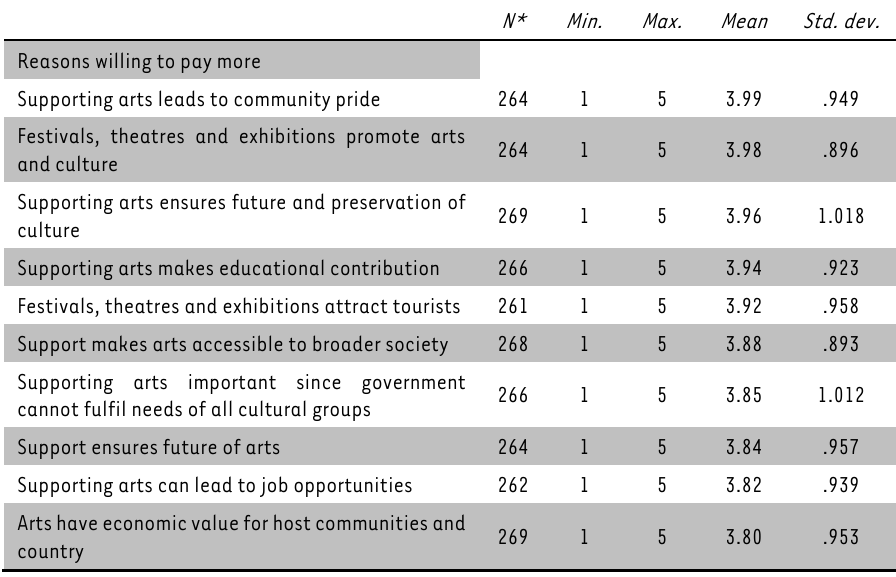
Descriptive results: reasons for being willing or unwilling to pay more to support